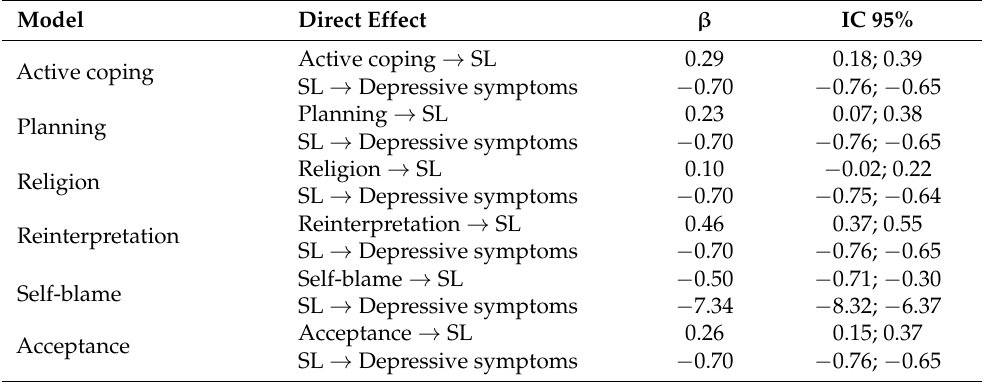
Table 4. Direct effects between